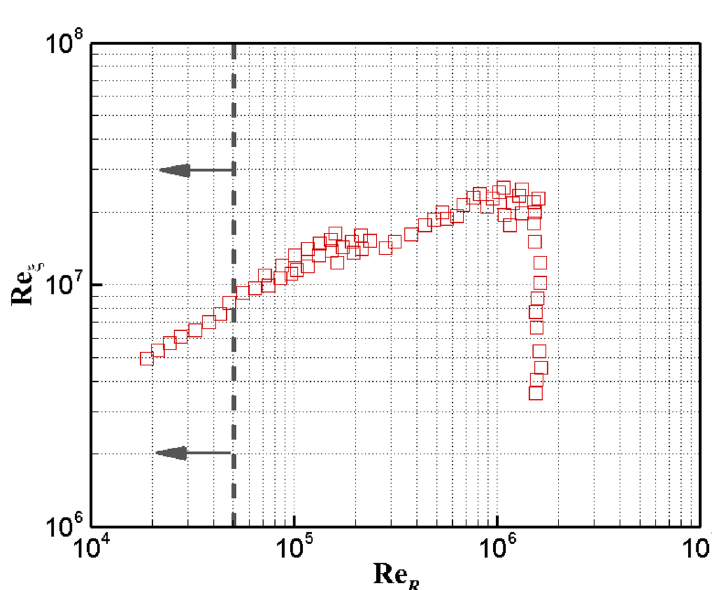
Fig. 4 Transition Reynolds number based on freestream as a function of the nose Reynolds number at Mach 6 by Stetson and Rushton